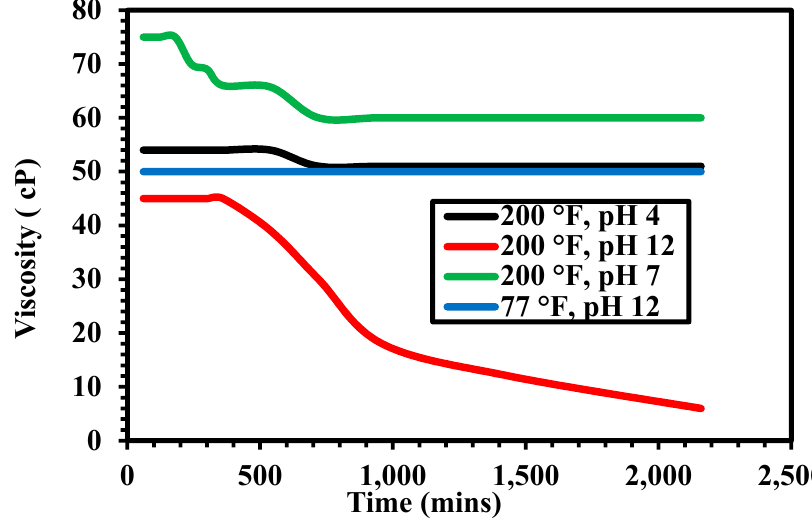
Figure 6. Apparent viscosity XC polymer (0.43 wt %) with GLDA (20 wt %) at different pH values (Shear rate- 170.3 s − 1 , P = 300 psi).